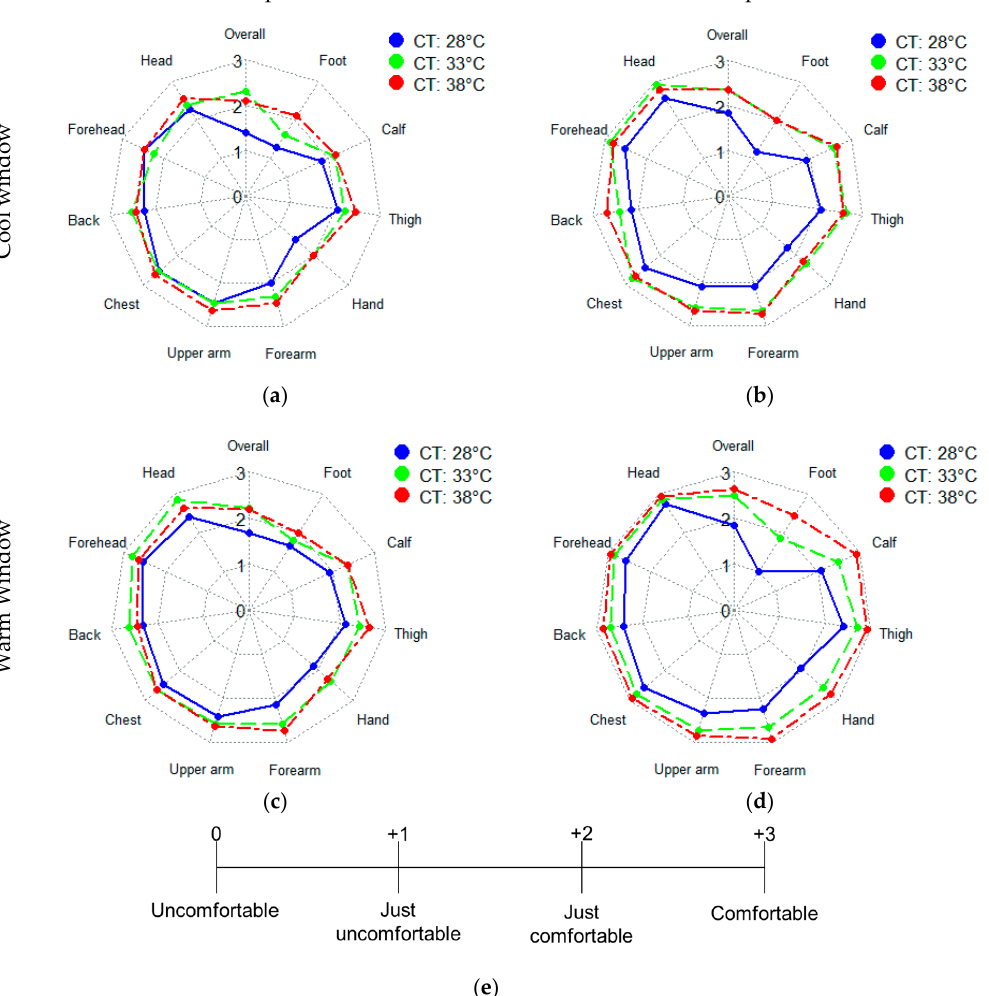
Figure 9. Average of overall/local thermal comfort votes in 12 different experimental scenarios. A combination of scenarios is presented in Figure 2 and Table 3. ( a ) Scenario group-1 related to the cool window and the front position; ( b ) Scenario group-2 related to the cool window and the rear position; ( c ) Scenario group-3 related to the cool window and the rear position; ( d ) Scenario group-4 related to the warm window and the rear position; ( e ) 4-point thermal comfort scale.